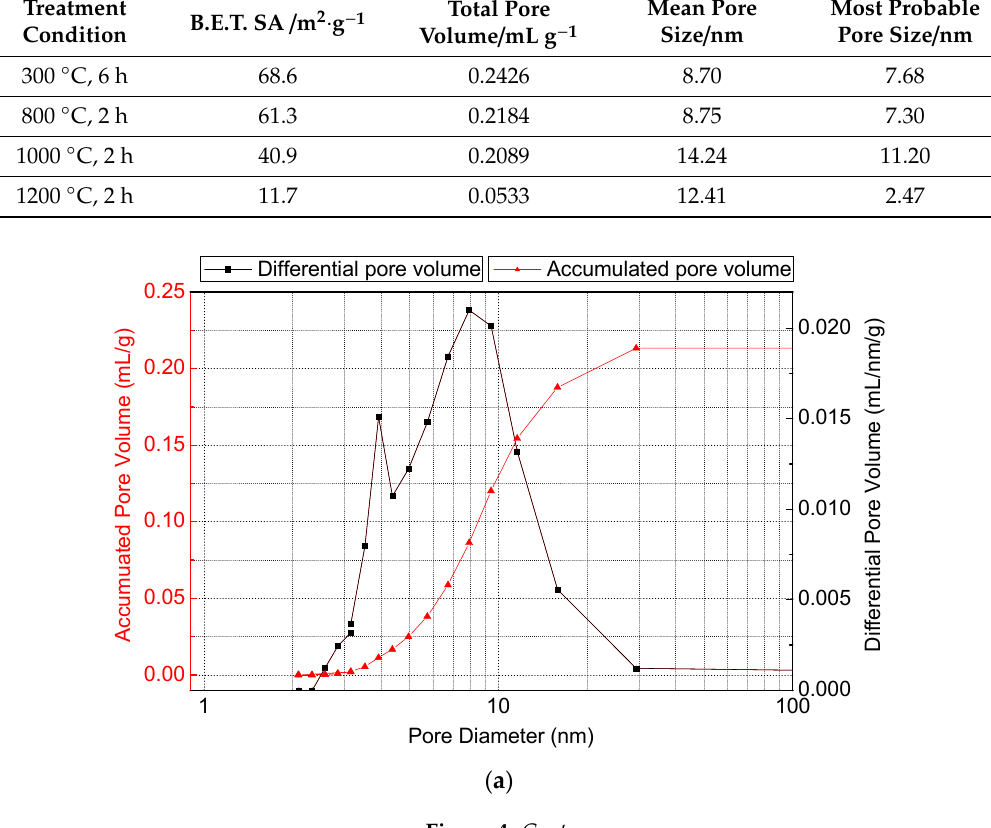
Table 5. B.E.T. (Brunauer, Emmett, and Teller) surface area and pore size parameters of calcined sample #1.